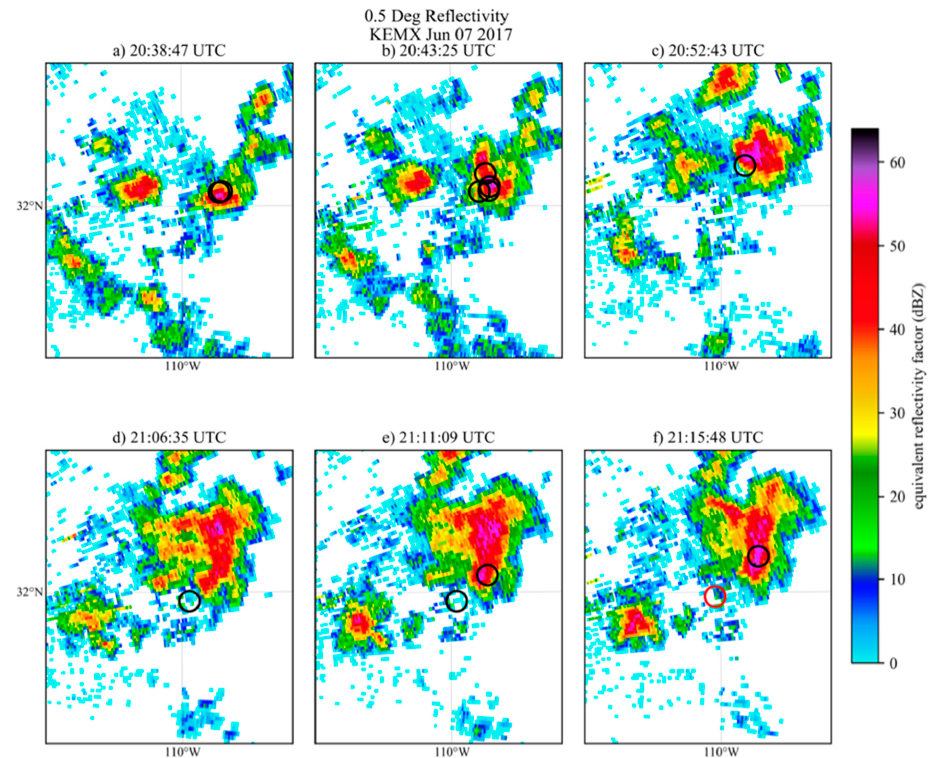
Figure 10. Base reflectivity (dBZ) at Tuscon, AZ superimposed with CG flashes that occurred during a 2-h period starting at 2038 UTC 7 June 2017 [45]. Black circles represent the NFS flashes, and the red circle denotes the single FS flash of the Lizard Fire. Table 3. CG flashes occurring the same day as the Lizard Fire initiation and their corresponding precipitation measurements, with the FS flash highlighted.